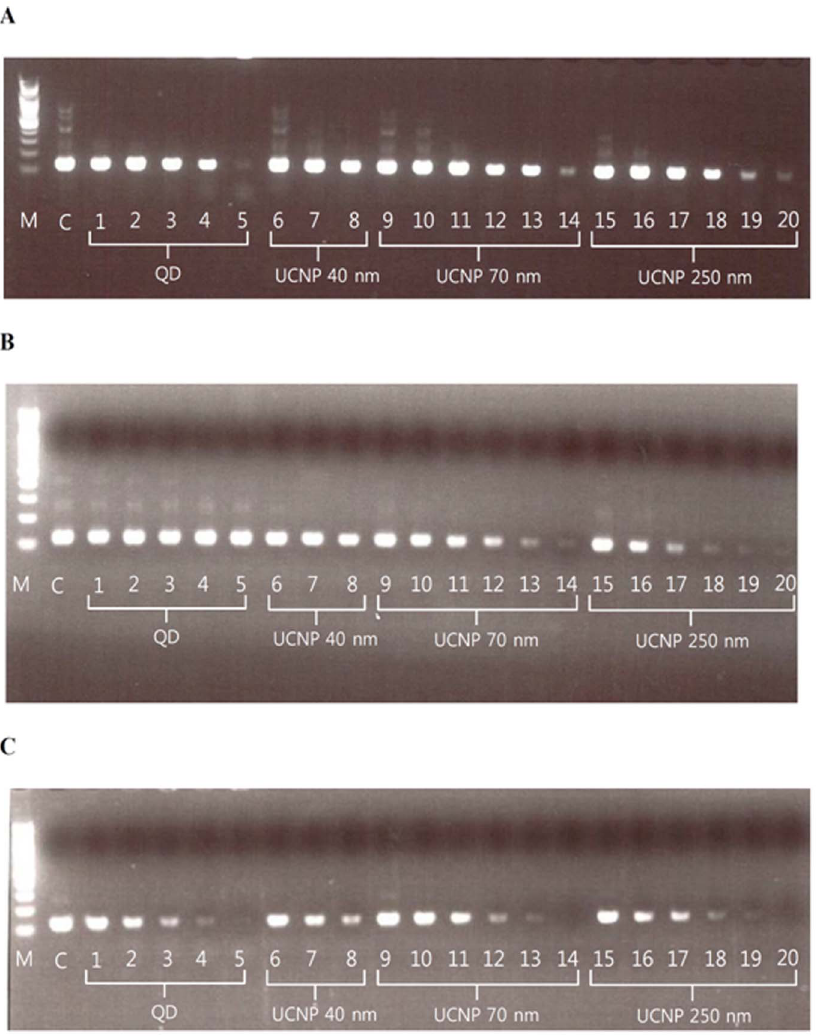
Figure 2. Effects of different concentrations and sizes of UCNPs on PCR amplification specificity. Three commercial real-time PCR master mixes were applied to determine the effects of different concentrations and sizes of UCNPs on the specificity of PCR amplification of a 120 bp 5S rDNA fragment from soybean genomic DNA, at an annealing temperature of 50 u C. ( A ) AccuPower PCR PreMix with Top Polymerase (Bioneer). ( B ) AmpliTaq Gold 360 Master Mix with AmpliTaq Gold DNA Polymerase (Applied Biosystems). ( C ) HotStarTaq Plus Master Mix with HotStarTaq DNA Polymerase (Qiagen). Lane M: DNA marker; lane C: template without UCNPs; lanes 1 , 5:5, 7.5, 10, 15, and 30 nM of QDs, respectively; lanes 6 , 8:0.5, 0.75, and 1.0 m g/ m L of 40-nm-sized UCNPs, respectively; lanes 9 , 14:1 6 (=2.4 6 10 5 particles/ m L), 10 6 , 15 6 , 20 6 , 25 6 , and 30 6 of 70-nm-sized UCNPs, respectively; lanes 15 , 20:1 6 , 10 6 , 15 6 , 20 6 , 25 6 , and 30 6 of 250-nm-sized UCNPs, respectively.